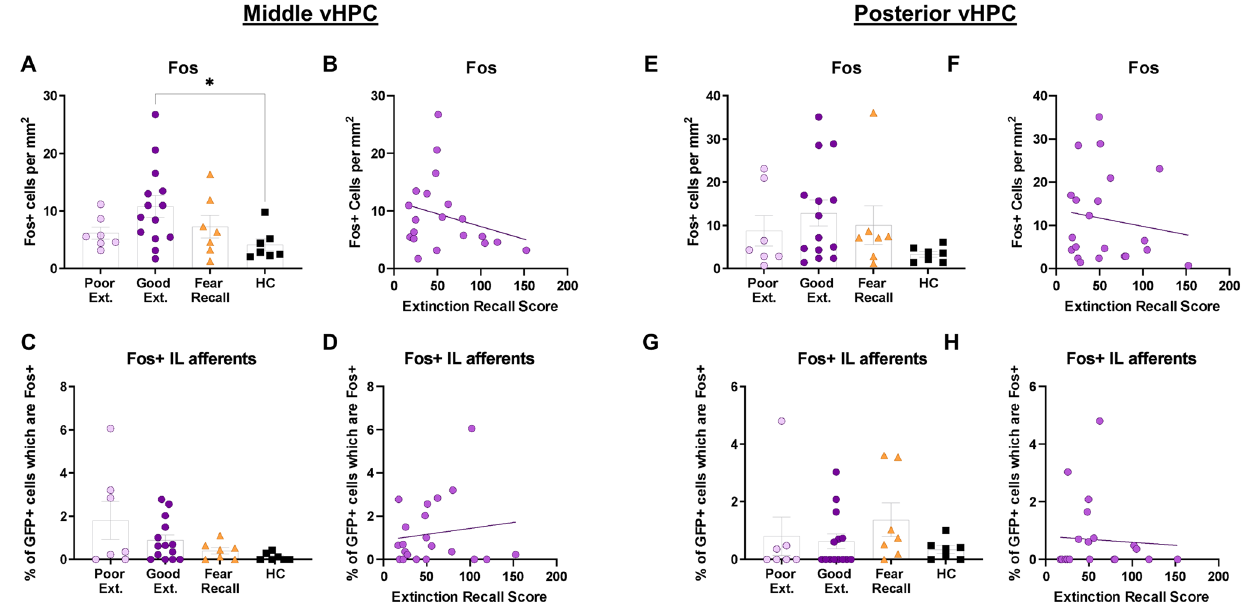
Figure 7. Elevated Fos expression in the middle ventral hippocampus of rats displaying good extinction recall. ( A ) Good extinction group, but not other group, shows elevated Fos expression relative to the home cage group in the mvHPC. ( B ) No significant correlation between Fos expression and extinction recall in the mvPHC. ( C ) No significant differences among groups in Fos expression within IL-afferents of the mvHPC. ( D ) No significant correlation between Fos expression within IL-afferents and extinction recall in the mvHPC. ( E ) No significant differences among groups in Fos expression in the pvHPC. ( F ) No significant correlation between Fos expression and extinction recall in the pvHPC. ( G ) No significant differences among groups in Fos expression within the IL-afferents of the pVHPC. ( H ) No significant correlation between Fos expression within IL-afferents and extinction recall in the pvHPC. Error bars represent standard error of the mean. * p < 0.05. Our primary analysis for all regions report comparisons at three levels along the anterior-posterior axis, although we also analyzed each regions collapsed across the AP axis. Results from these analyses are depicted in Table 1.